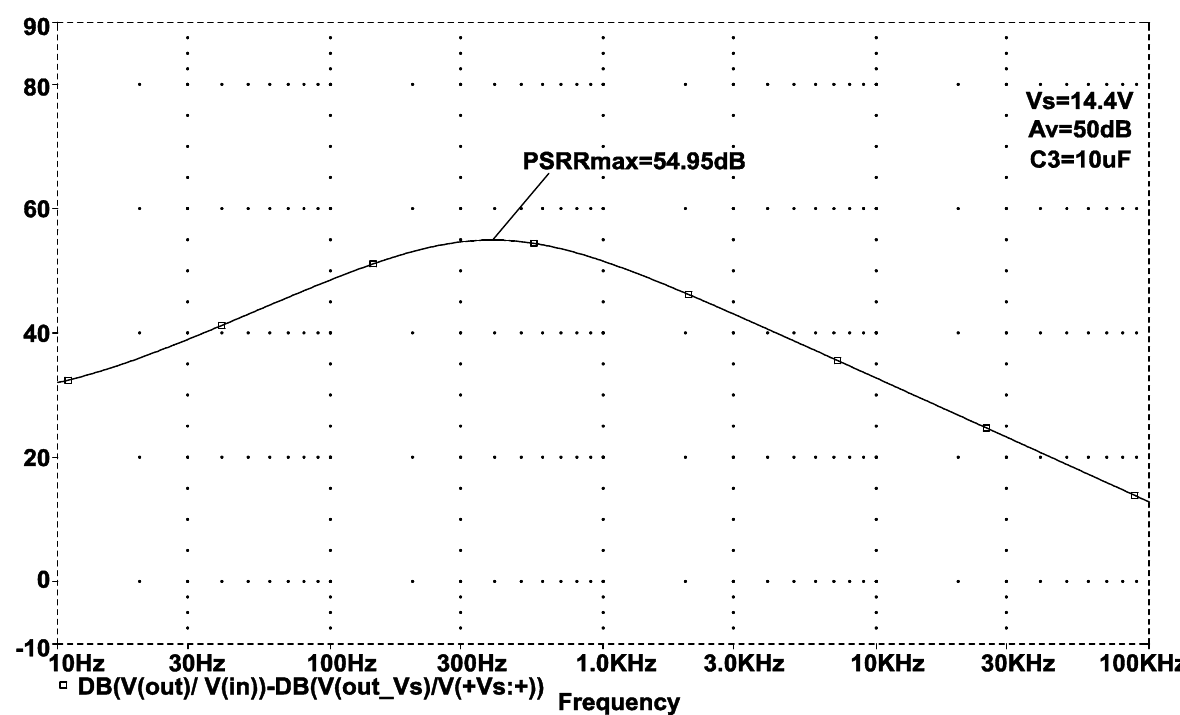
Figure 8. Simulated power supply rejection ratio versus frequency.